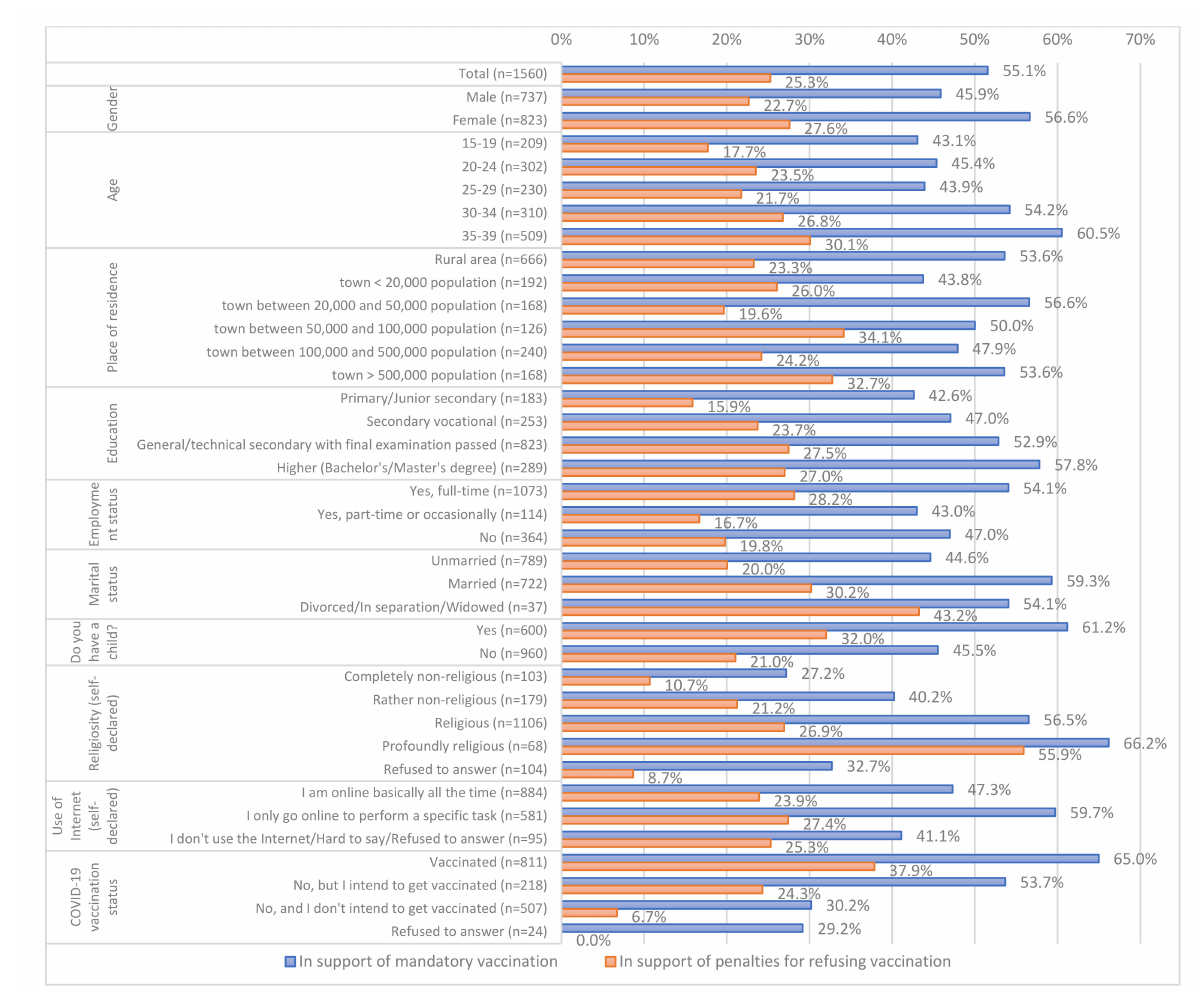
Figure 1. The percentages of respondents declaring that preventive vaccination against the most dangerous infectious diseases should be mandatory and the percentages of respondents accept- ing legal or financial sanctions against those who refuse mandatory vaccination of their children ( n =